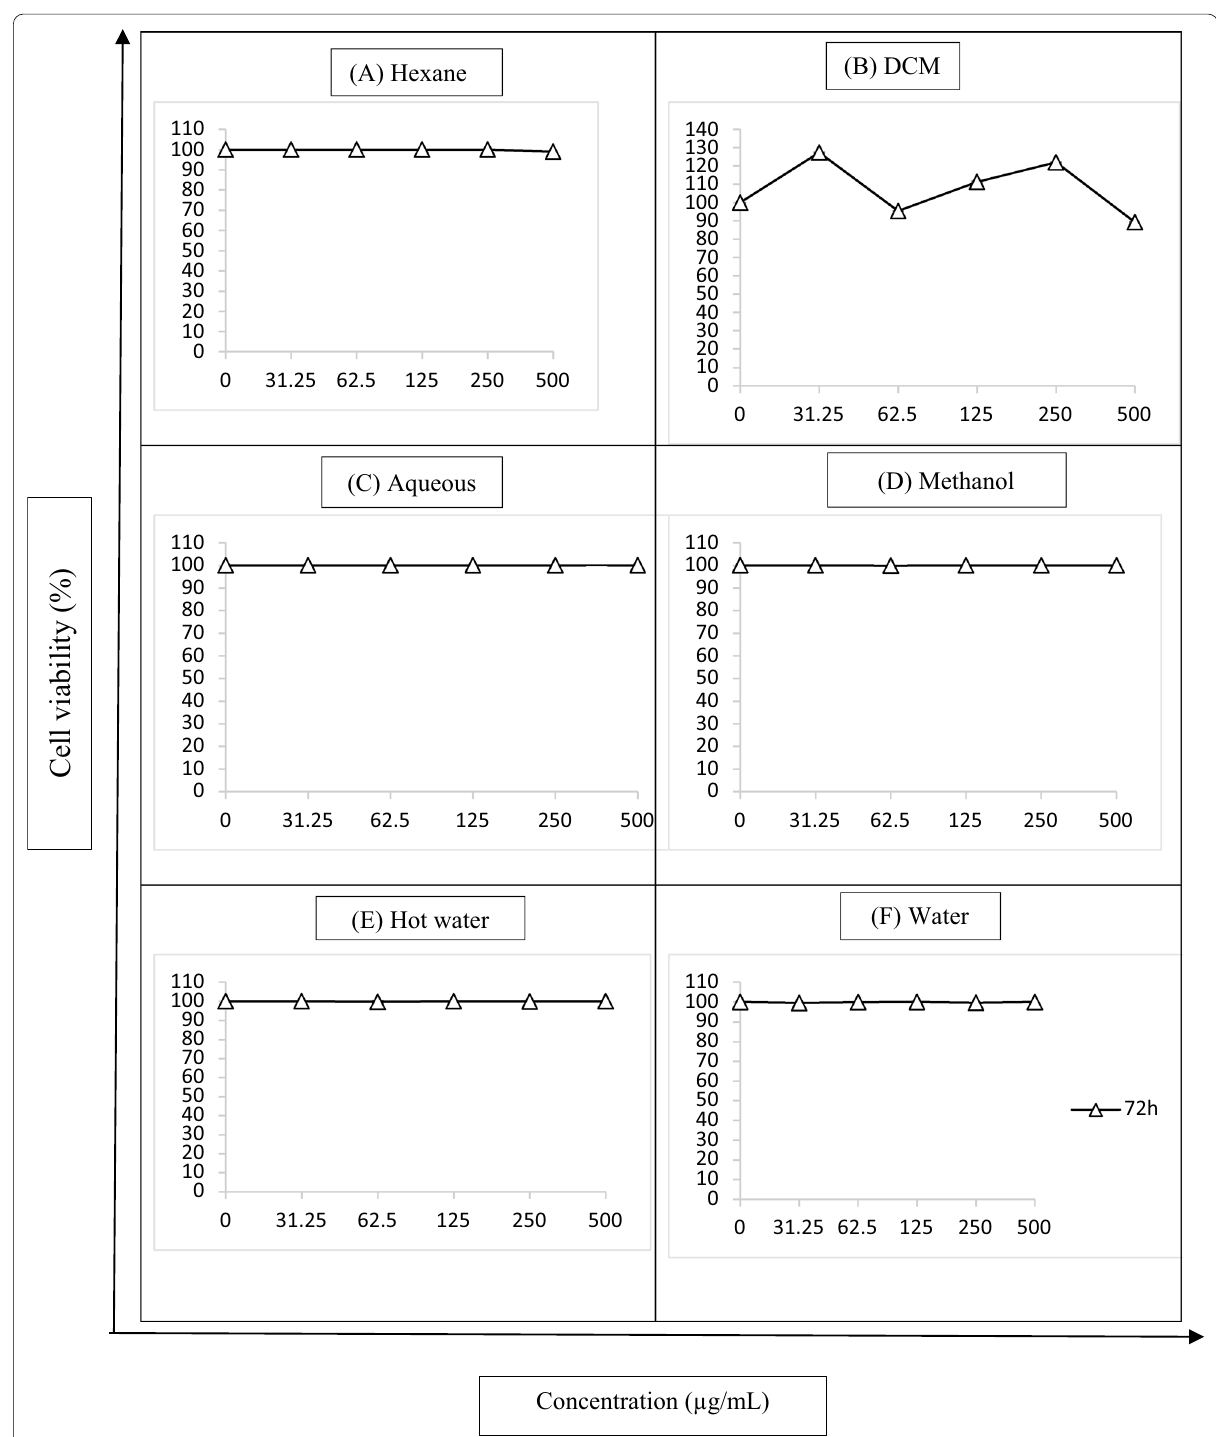
Fig. 4 Antiproliferative effects of Clinacanthus nutans fractions extracts in MCF-10A cell lines. The cancer cells were incubated and treated with increasing concentrations of different solvent extracts (hexane, DCM, aqueous, methanol, hot water and water). Various concentrations were used from 31.25 to 500 µg/mL for 24, 48 and 72 h. The antiproliferative effect was measured by SRB assay. Data shown are the mean values independent experiments, and statistical analysis was determined using Student’s T test with * P < 0.05 significantly different to control